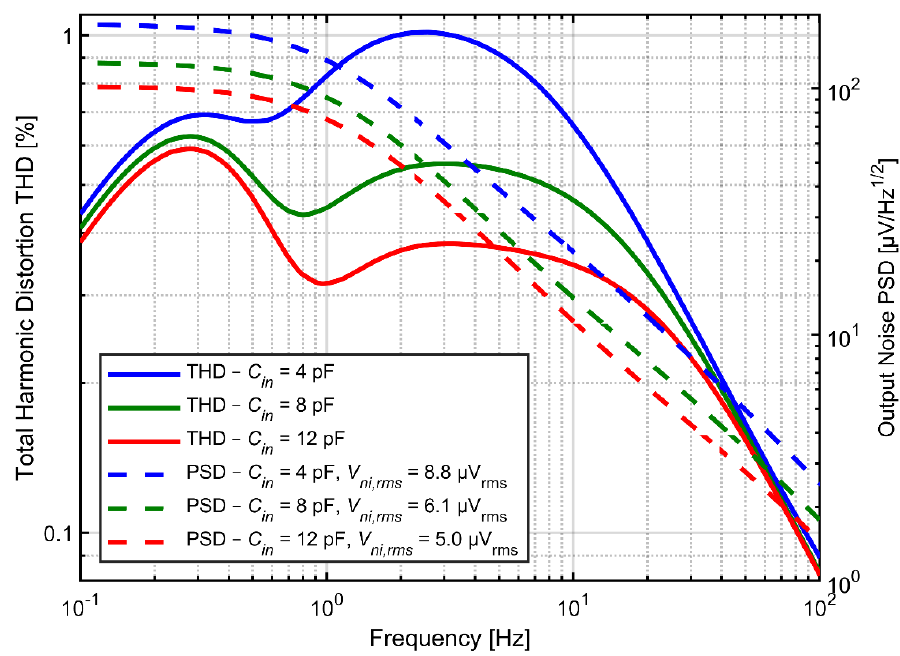
Figure 8. THD as a function of input signal frequency and output noise PSD for various values of C in and C f with fixed ratio C in /C f = 20. Cutoff frequency is fixed at 1